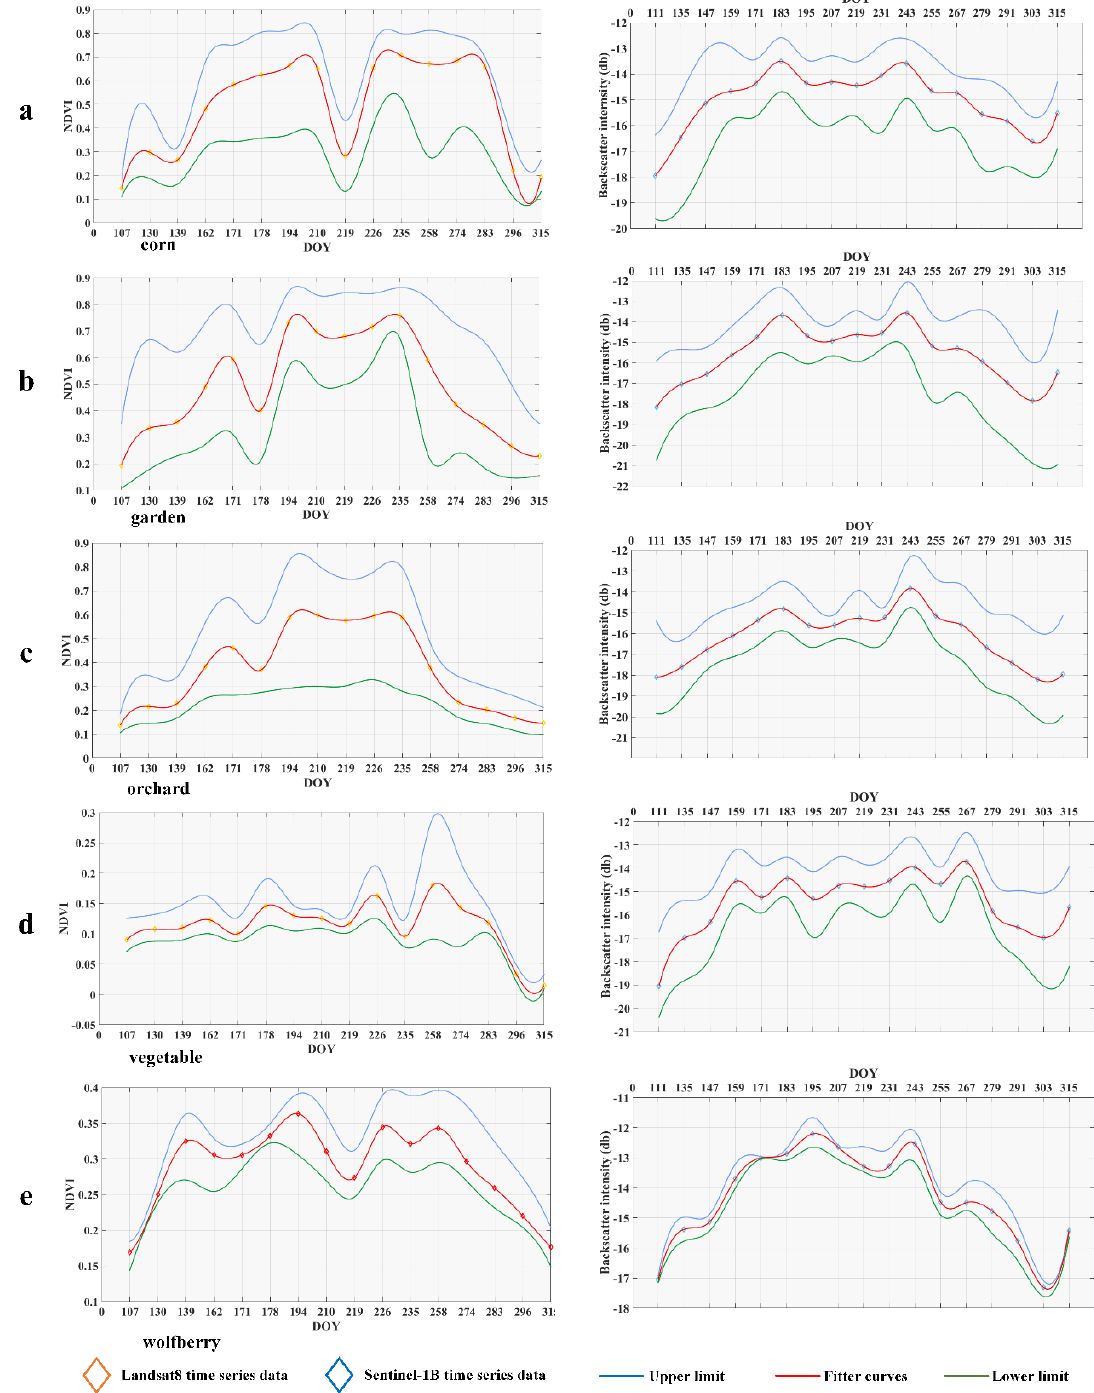
Figure 8. Characteristic curves of crops in Zhongning County: the same row represents the same crop. The left-column data belong to Landsat-8, and the right-column data belong to Sentinel-1 with VH polarization. ( a ) Corn and winter wheat; ( b ) garden; ( c ) orchard; ( d ) vegetable; and ( e ) wolfberry.